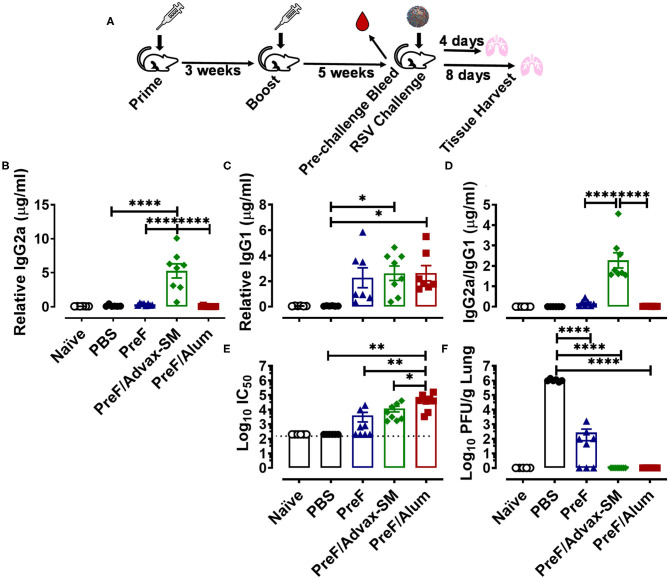
The Th2-biased humoral immunity of PreF/Alum and the Th1 skewed-humoral immunity of PreF/Advax-SM protect from RSV challenge. At 7–8 weeks of age, female adult BALB/cJ mice were immunized with phosphate buffered saline vehicle control (naïve & PBS), prefusion RSV F protein alone (PreF), or PreF formulated with Advax-SM (PreF/Advax-SM) or Alum (PreF/Alum) as depicted in (A). Six weeks post-boost, pre-challenge serum was collected and mice were subsequently intranasally challenged with vehicle (naïve) or 5 × 105 PFU/gram of RSV Line 19. Animals were culled for sample collection at 4 or 8 days post infection (dpi) (A). Pre-challenge serum was analyzed for PreF-specific IgG2a (B), IgG1 (C), IgG2a to IgG1 ratios (D) and neutralizing antibody titers (E). At 4 dpi, left lungs were harvested and virus quantified using standard H&E plaque assays (F). Data are represented as mean ± SEM (n = 6-8 mice per group);*p < 0.05, **p < 0.01, and ****p < 0.0001. Due to a lack of pre-existing PreF-specific antibody, PBS was not included in the analysis in (D).